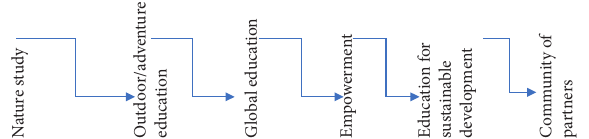
Figure 1: Different aspects of emphasis on environmental education